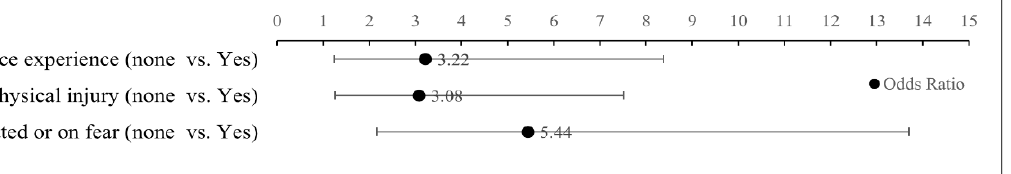
Figure 3. The main results of this